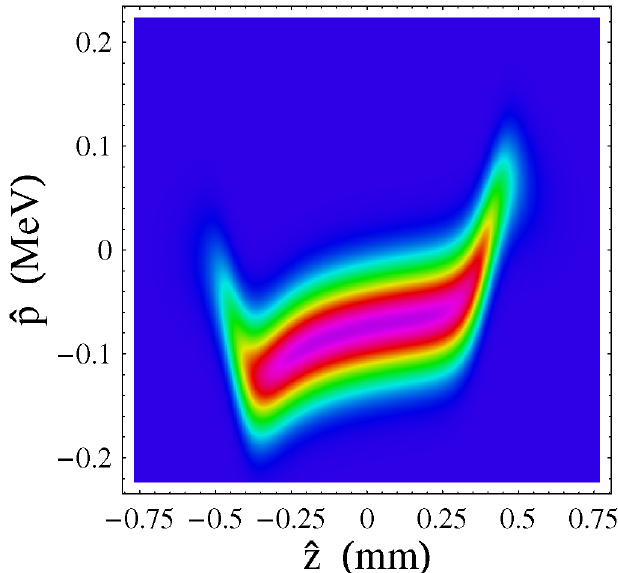
FIG. 3. (Color) Beam density function in the (cid:2) ^ z; ^ p (cid:4) phase space at the exit of a bunch compressor and in the presence of CSR. The head of the bunch is at ^ z > 0